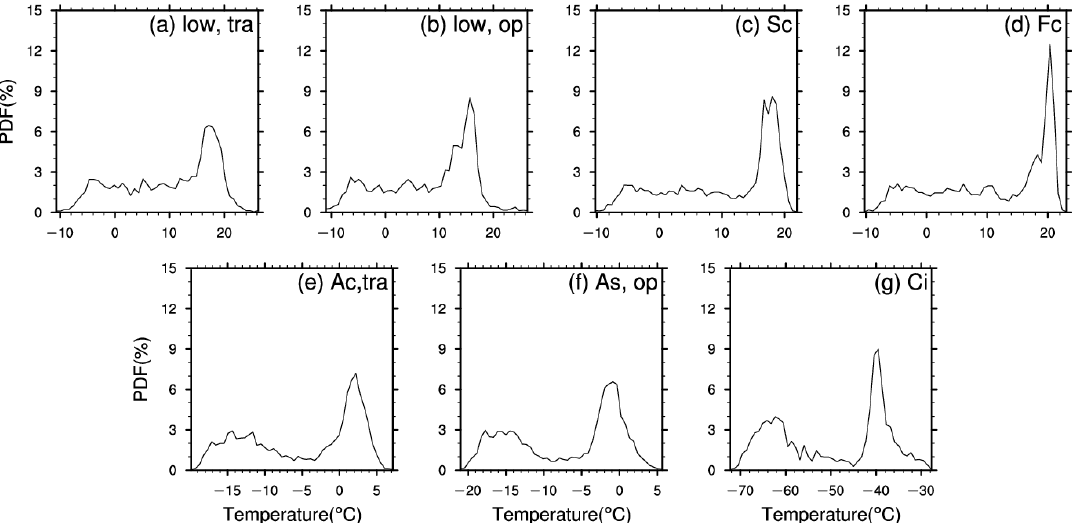
Figure 11. Probability density of temperature in the cloud: ( a ) low overcast (transparent), ( b ) low over- cast (opaque), ( c ) stratocumulus, ( d ) low broken cumulus (transparent), ( e ) altocumulus (transparent), ( f ) altostratus (opaque) and ( g )